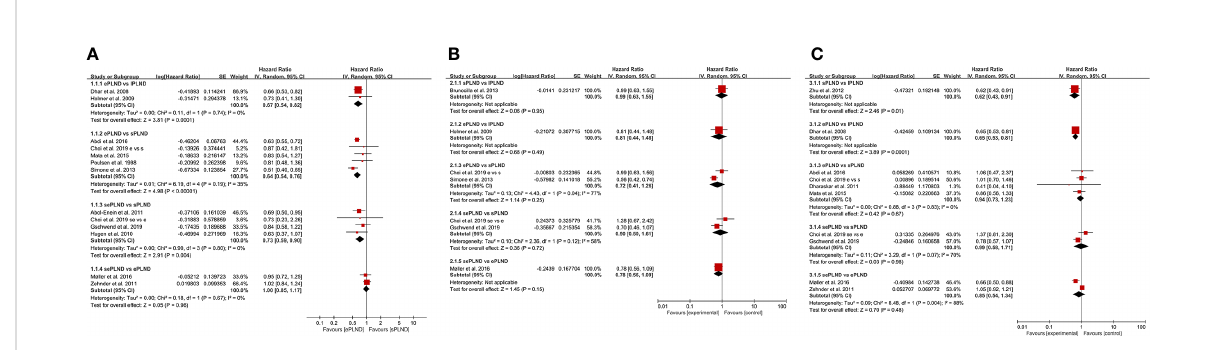
FIGURE 2 (A) Forest plot for direct comparisons of RFS in patients with different PLND templates. (B) Forest plot for direct comparisons of DSS in patients with different PLND templates. (C) Forest plot for direct comparisons of OS in patients with different PLND templates. RFS, Recurrence free survival. PLND, Pelvic lymph node dissection. DSS, Disease speci fi c survival. OS, Overall survival. CI, con fi dence interval. lPLND, limited pelvic lymph node dissection. sPLND, standard pelvic lymph node dissection. ePLND, extended pelvic lymph node dissection. sePLND, super-extended pelvic lymph node